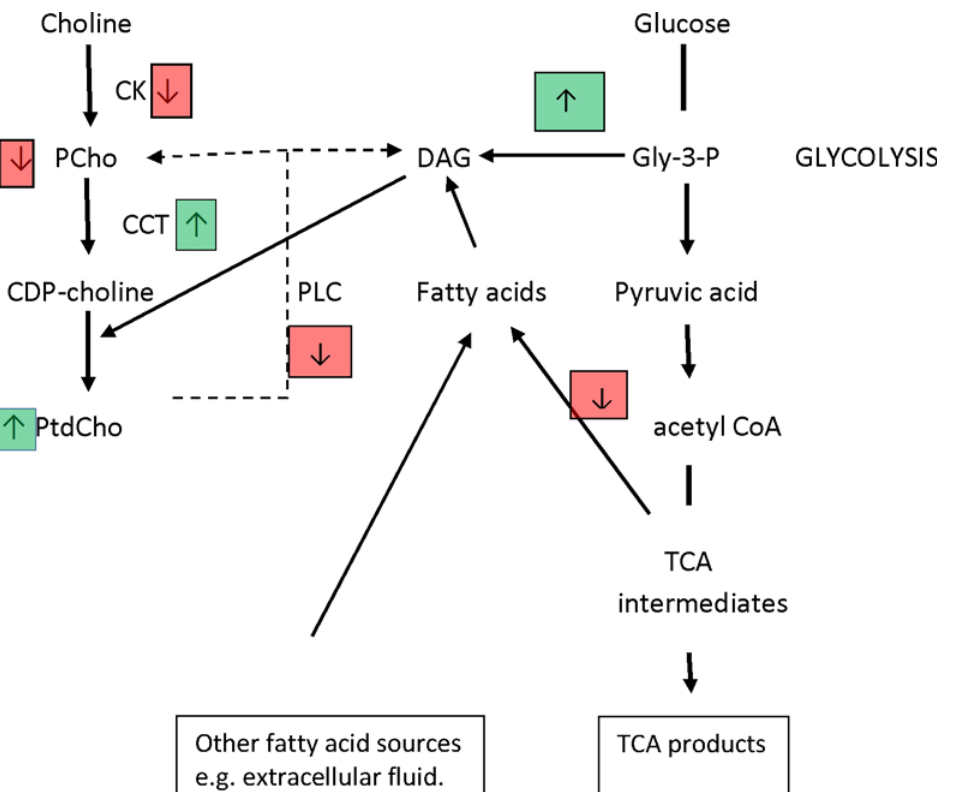
Fig 8. Alterations in phosphatidylcholine metabolism and conversion of glucose to fatty acid and glycerol associated with metformin treatment. (Abbreviations: PtdCho, phosphatidylcholine; PCho phosphocholine; CDP-choline, cytidine tri-phosphate – choline; CK, choline kinase; CCT, CTP: phosphocholine cytidylyltransferase; DAG diacylglycerol; PLC phospholipase C; TCA, tricarboxylic acid; Gly-3-P, glyceraldehyde-3-phosphate.